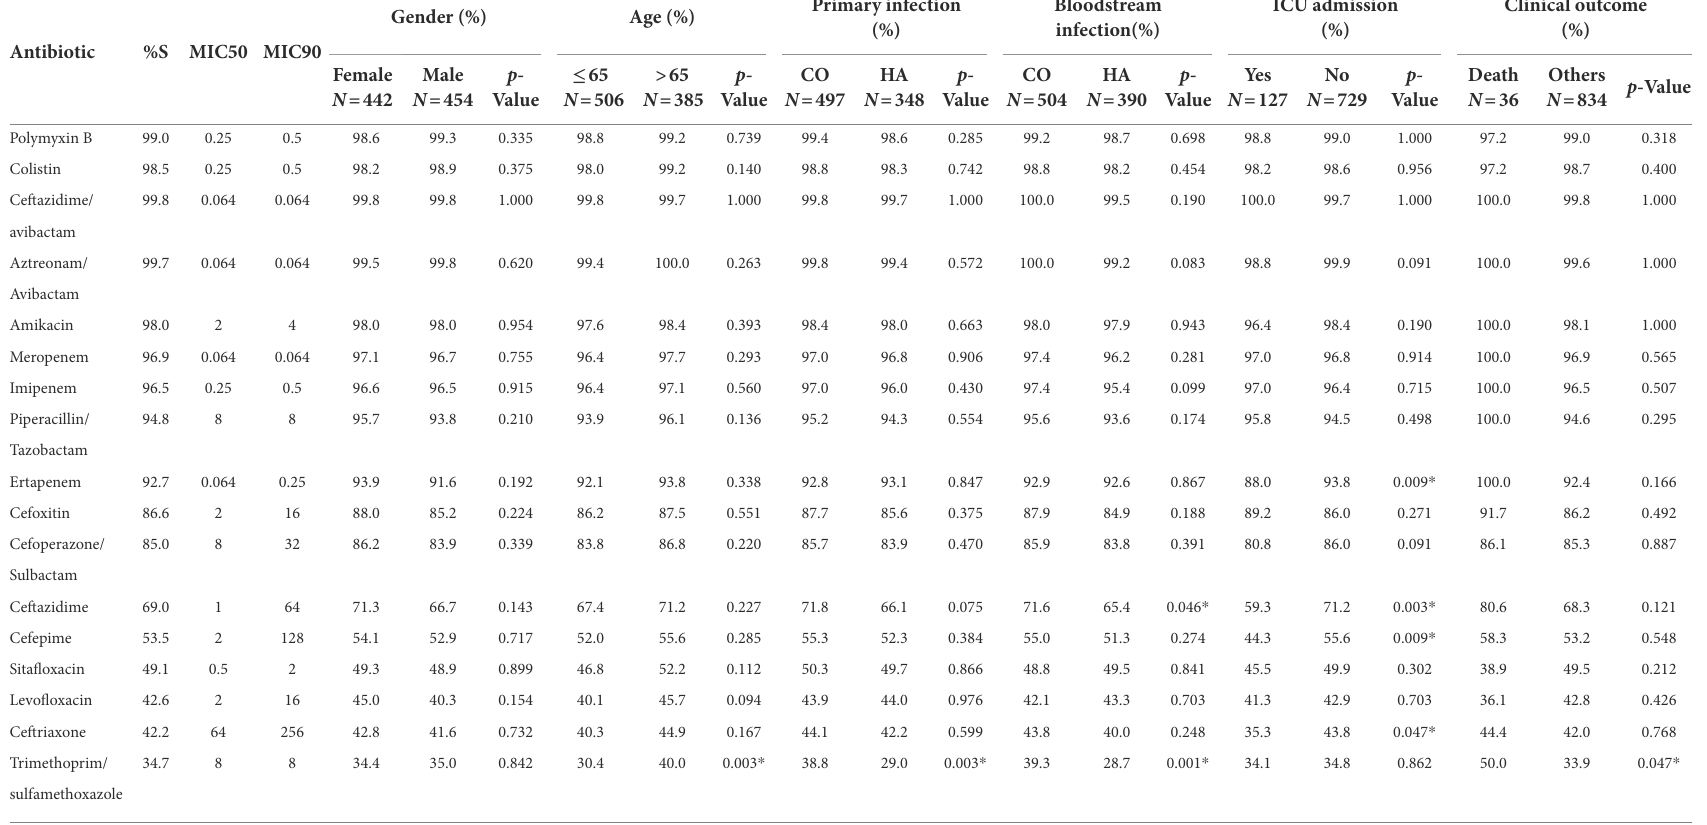
TABLE 1 Comparison of the antimicrobial susceptibility rates of Escherichia coli isolates in clinical features.